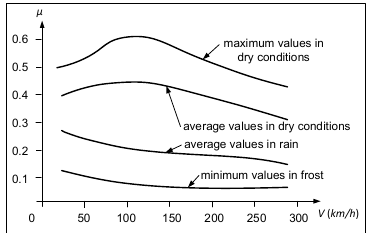
Figure 2. Railway adhesion traction.